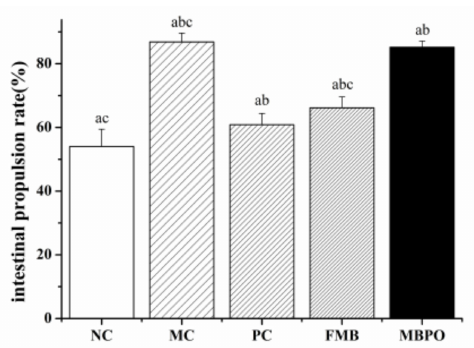
Figure 7. Intestinal mucosal SIgA content. a p < 0.05 vs. MC group. b p < 0.05 vs. NC group, c p < 0.05 vs. PC